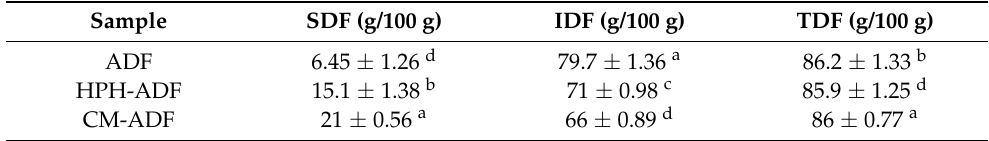
Table 2. Effect of modification on the content of